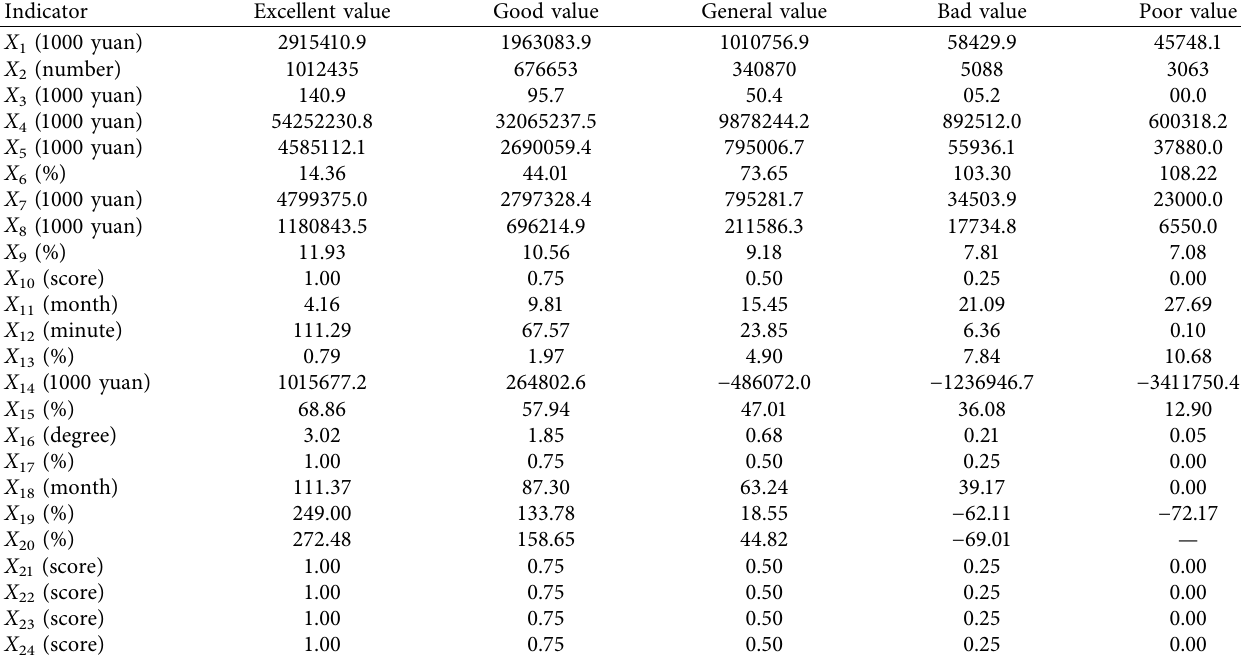
Table 7: The critical value of the rating 1–5 scale of 24 indicators.